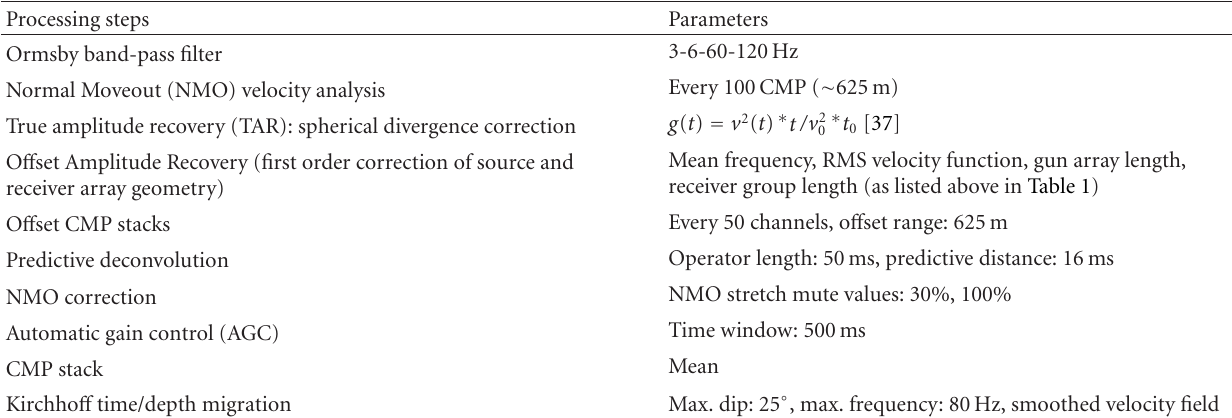
Table 2: The processing flow applied to profile BGR99-46 is divided into two parts. The o ff set stacks are created after the application of a band-pass filter and amplitude recovery, while the full CMP stack is created after an additional deconvolution and automatic gain control (AGC). Finally, the profile is either migrated in depth (for retrieving BSR depths) or migrated in time (for BSR interpretation).